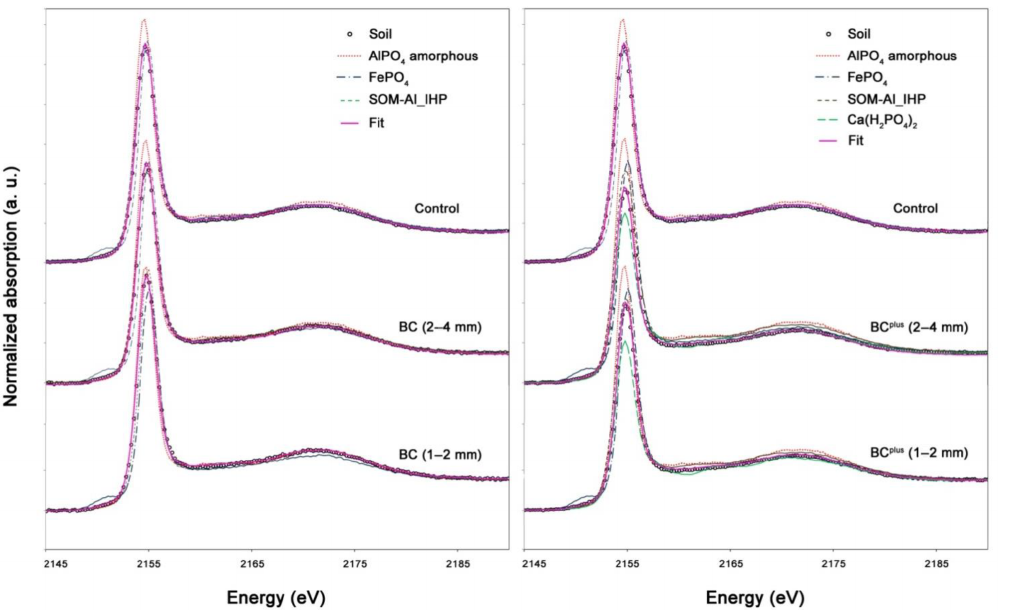
Figure 3. P K -edge XANES spectra of unfertilized (control) and fertilized soils with BC and BC plus particles under a 70-day incubation- leaching experiment compared to the reference compounds selected by the LCF method.